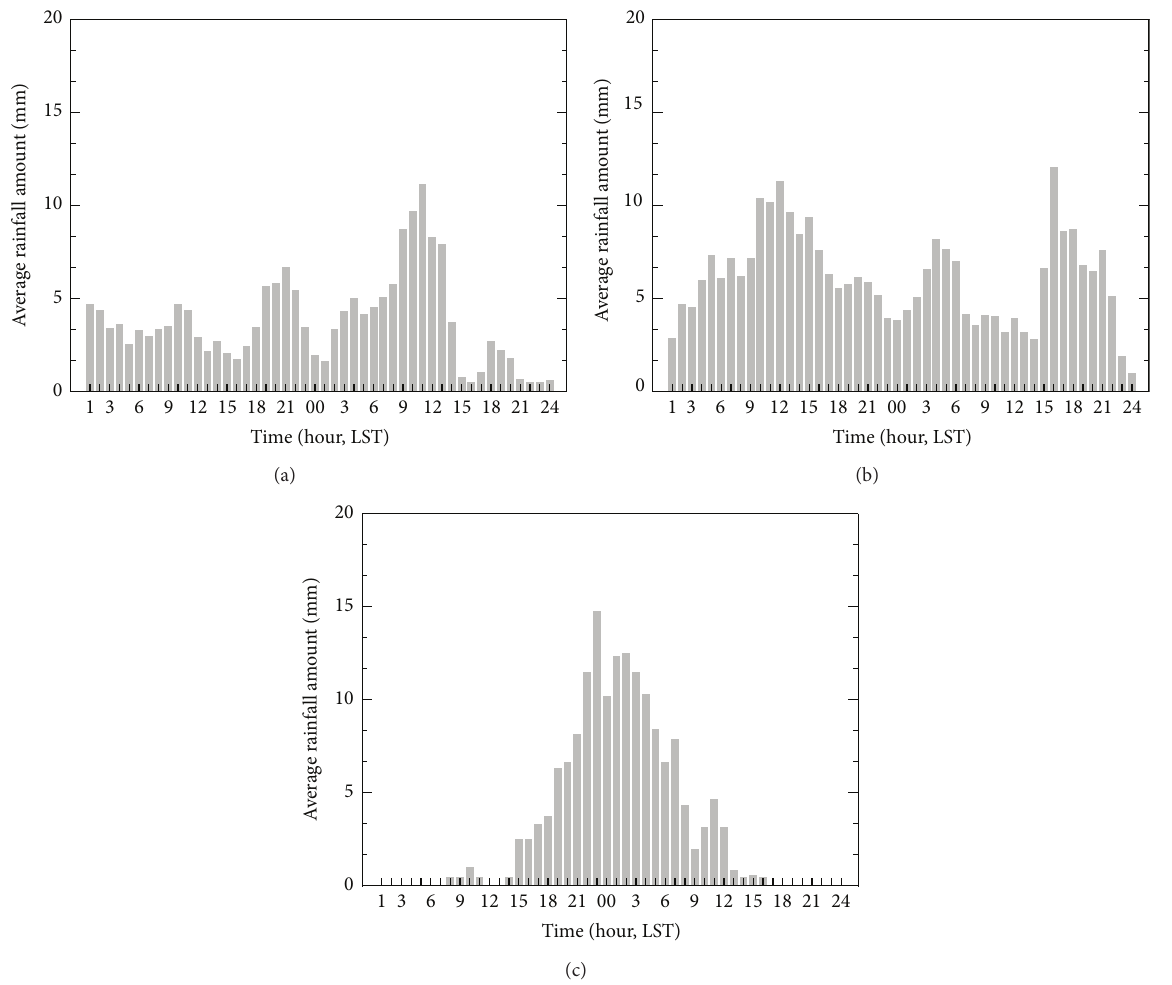
Figure 4: Time series of averaged rainfall amount, which was accompanied with (a) Changma front and typhoon, (b) Changma front only, and (c) typhoon only, averaged rainfall from all rain gages within radar coverage.